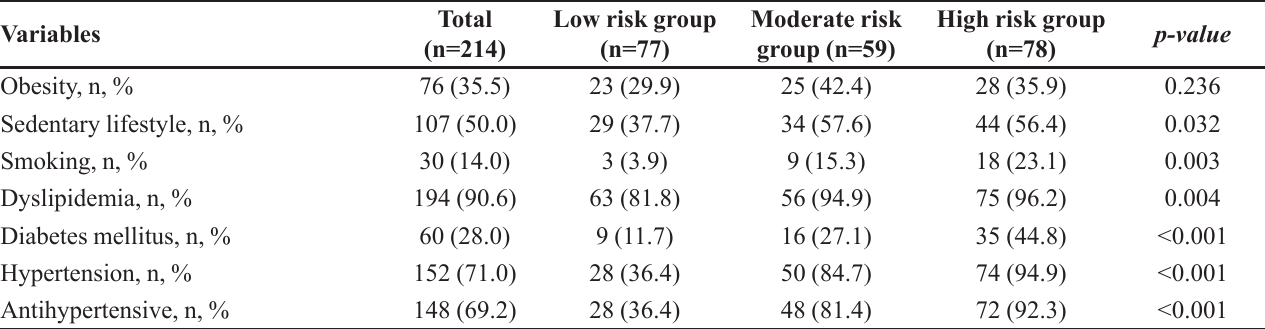
TABLE II ‑ Prevalence of traditional cardiovascular risk factors among the groups (FRS)